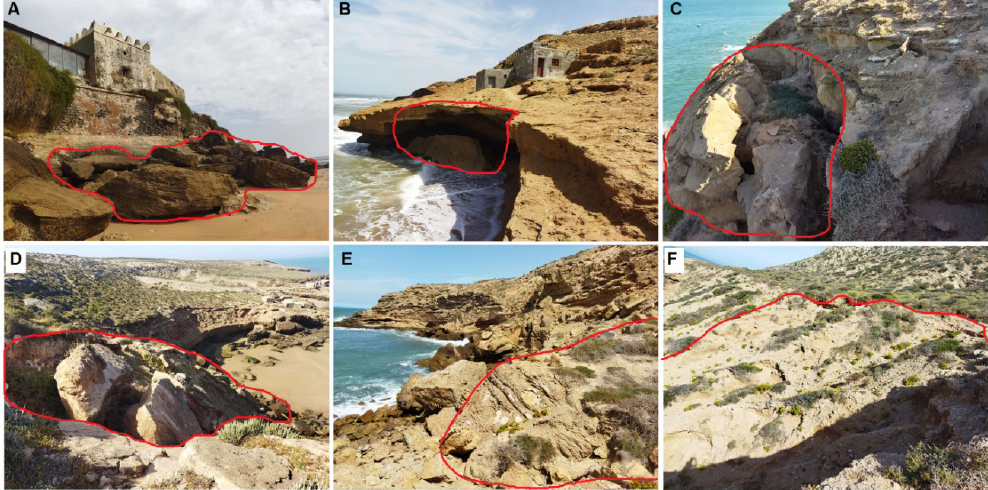
Figure 3. Some landslide type examples from the study area: (A, B) rock falls, (C) rock topple, (D) translational slide, (E) rotational slide with back tilting, and (F) debris